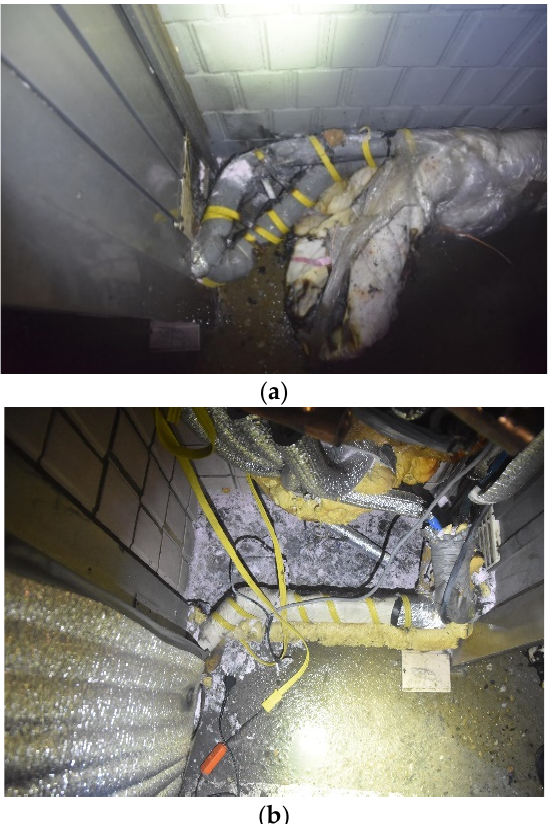
Figure 7. Fire caused by insulations around water service pipes and heating cables wrapped around them. ( a ) Case 2—Fire site ➀ . ( b ) Case 2—Fire site ➁ .